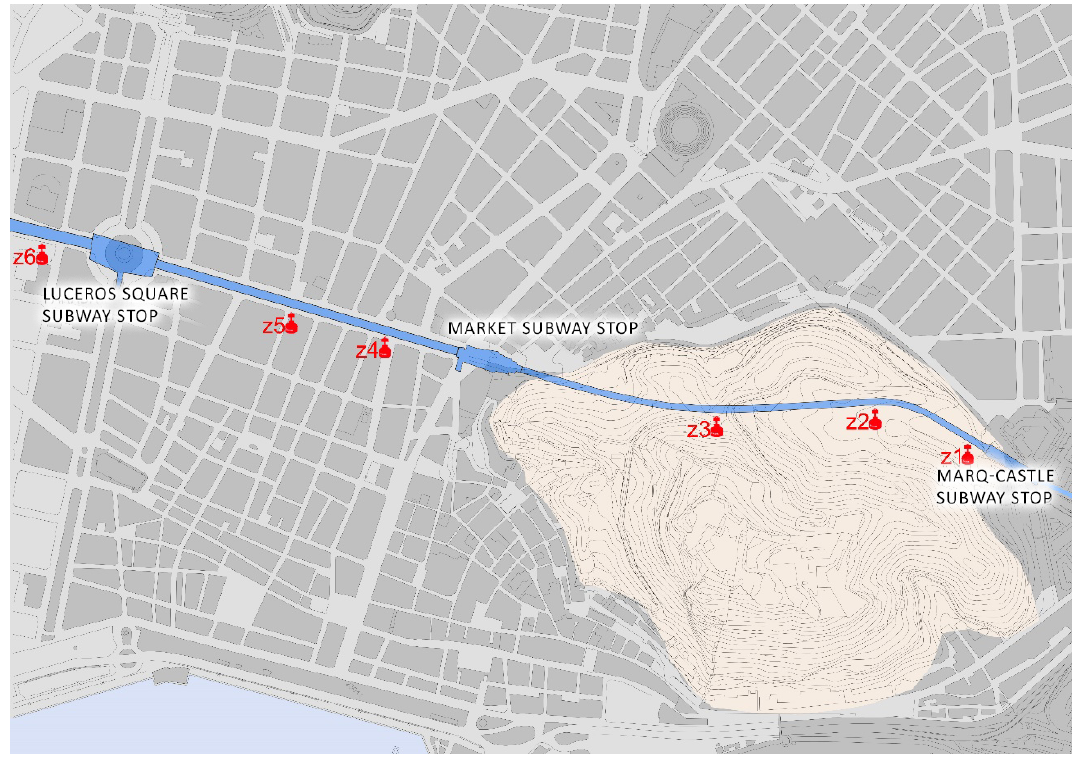
Figure 14. Image of the measuring points inside the